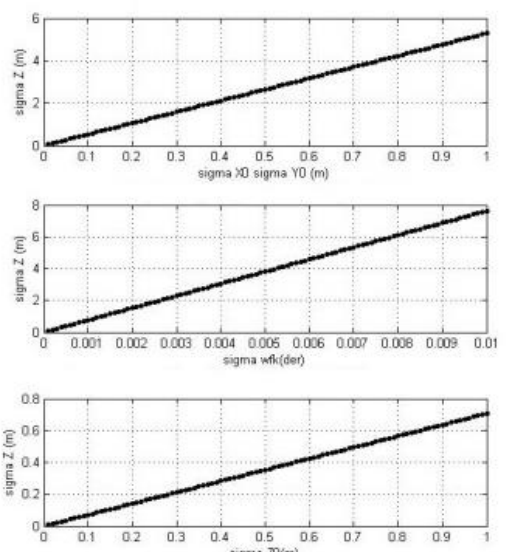
Figure 5.c-1 Effect of orientation parameters to on component Z